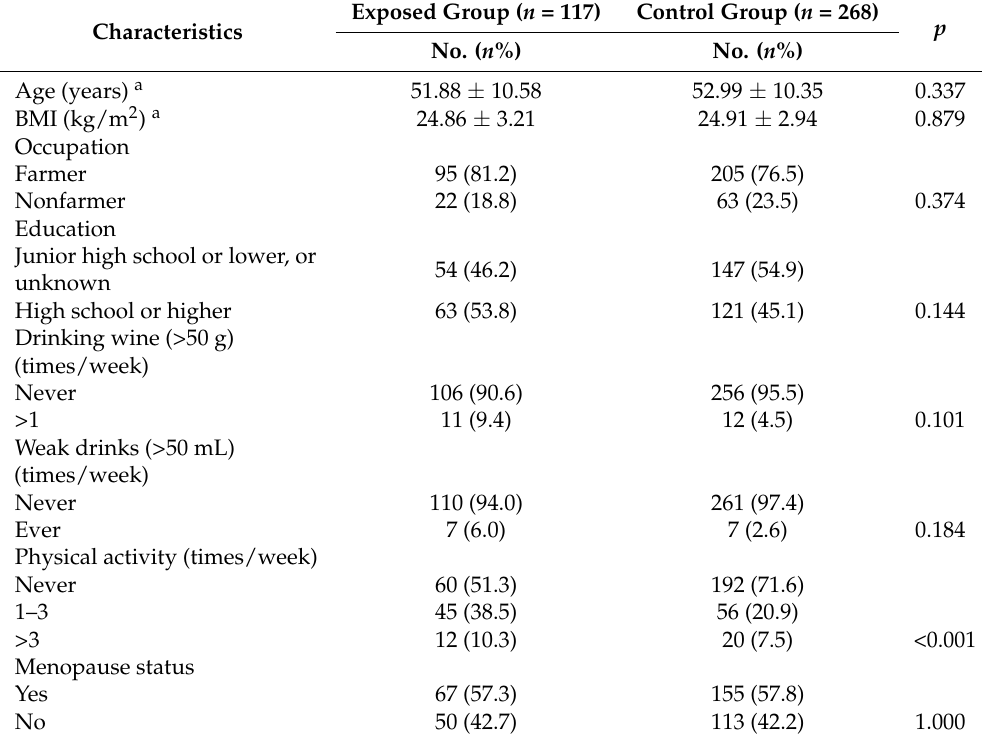
Table 1. Characteristics of included